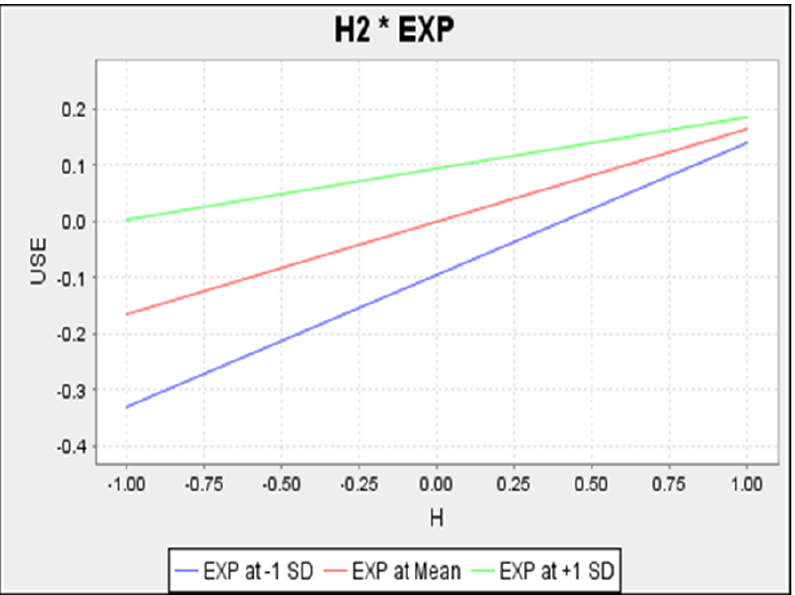
Figure 8. Simple Slope Analysis of Habit on Technology Use.